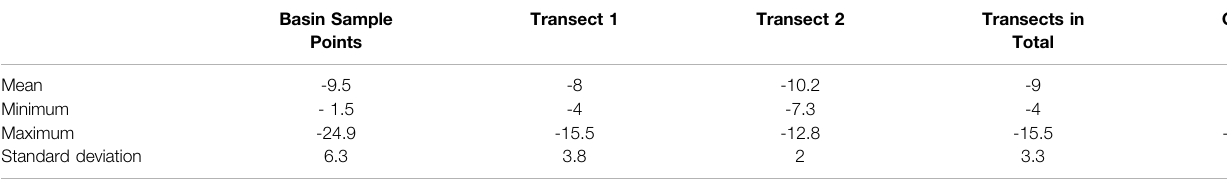
TABLE 4 | Basic descriptive statistics of annual soil redistribution rate (t ha − 1 yr − 1